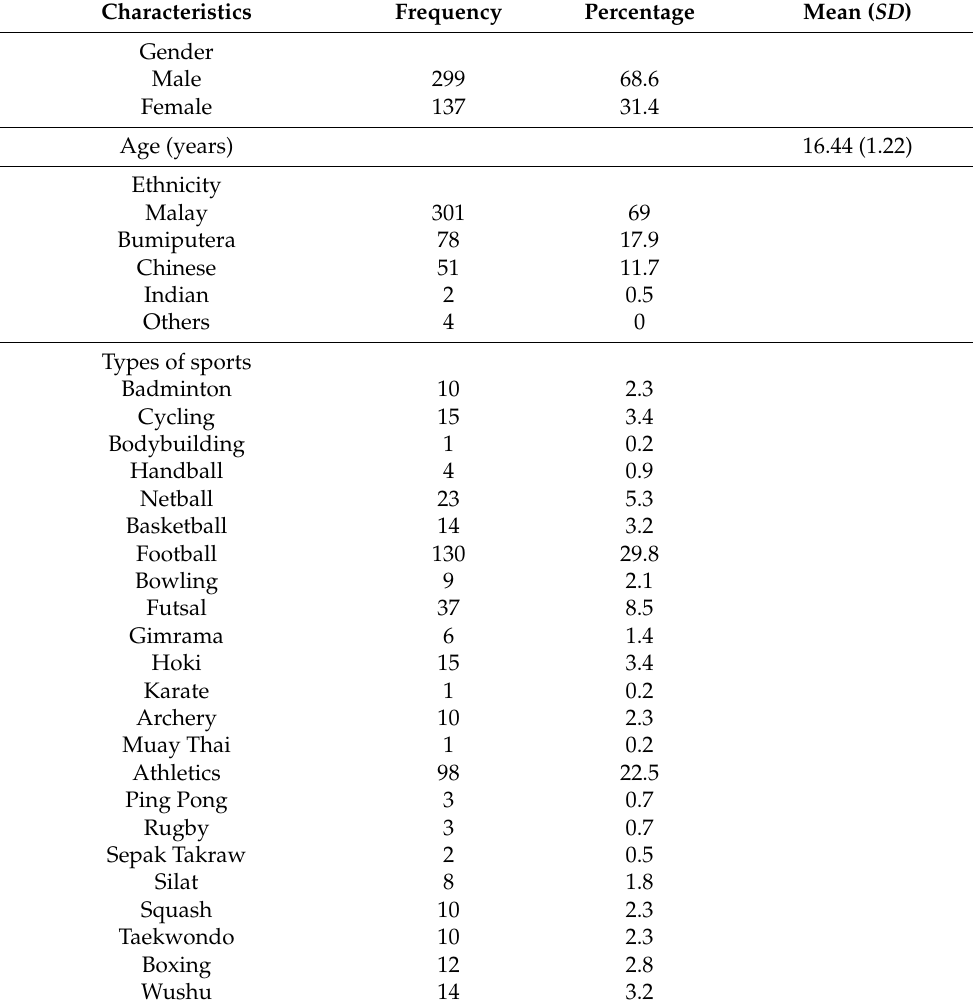
Table 1. The demographic characteristics of the athletes who are representative of state teams ( n =